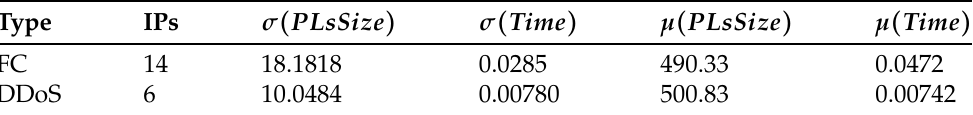
Figure 5. Discrimination of DDoS attack from FC based on the size of payload. Table 6. DDoS and FC traffic